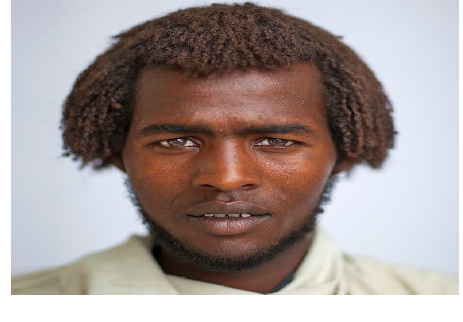
Figure 1. Yasee. Figure 1. Yasee. Humanities 2019 , 8 , x FOR PEER REVIEW